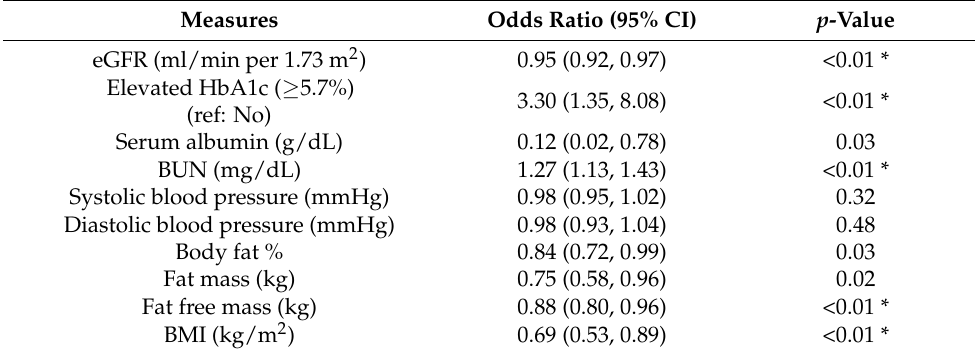
Table 5. Risk factor analysis comparing participants with anemia (Hb < 13 g/dL, n = 27) versus participants with normal hemoglobin (n = 176), controlling for age and